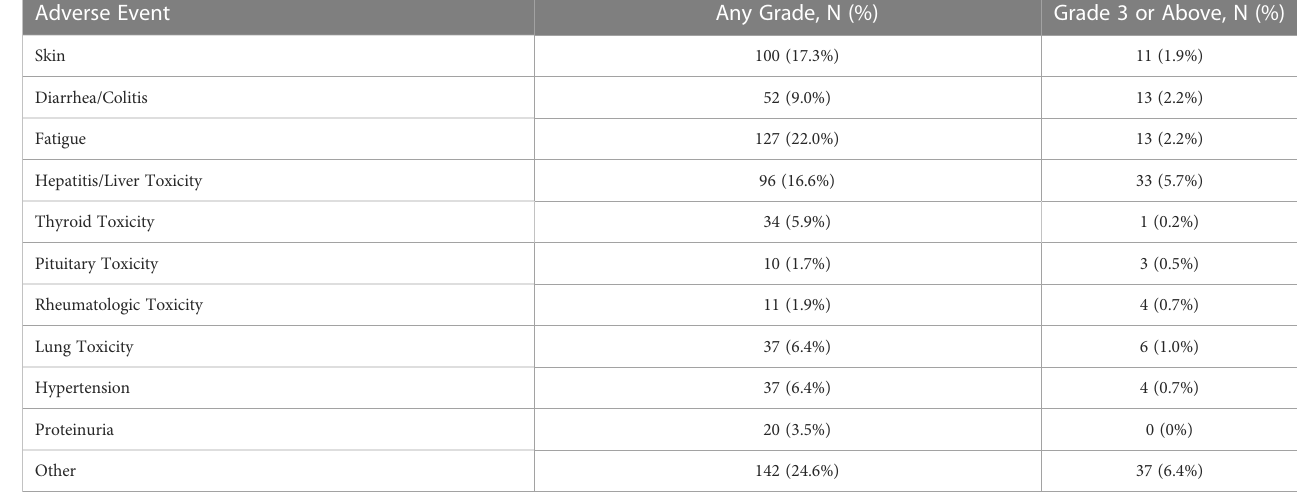
TABLE 2 Adverse